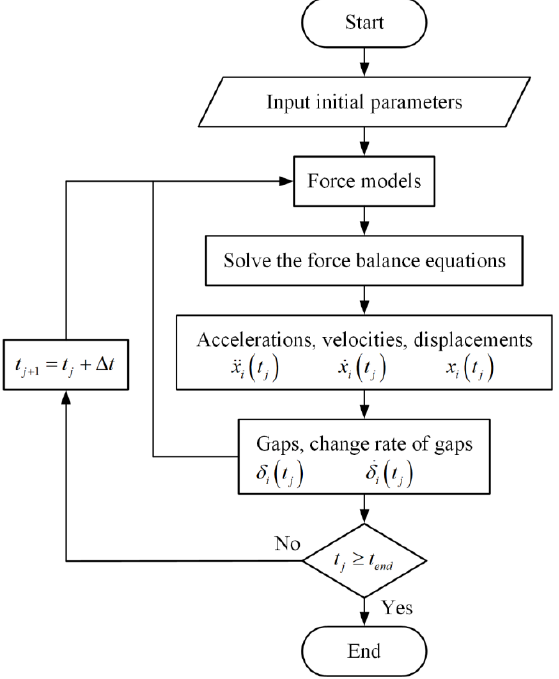
Figure 3. Flow chart of the simulation. At the beginning of the simulation, the wet multi-disc clutch is in the disengagement status (D), then goes through the engaging process (A), the engagement status (B), and the disengaging process (C), and finally goes back to the disengagement status under the control of hydraulic oil. The variation of hydraulic pressure P app is shown in Figure 4. From 0 s to 0.3 s, the hydraulic pressure increases linearly from 0 MPa to 0.36 MPa. From 0.3 s to 0.5 s, the hydraulic pressure continues to increase linearly from 0.36 MPa to 1.8 MPa and then keeps constant. The disengaging process starts when the hydraulic pressure starts to decline at 1.5 s. From 1.5 s to 1.6 s, the hydraulic pressure declines rapidly from 1.8 MPa to 0.05 MPa and then declines slowly to 0 MPa at 5